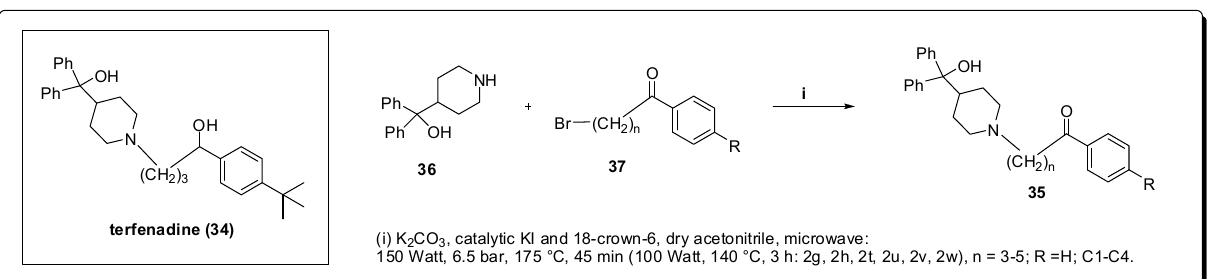
Figure 11. Synthesis of terfenadine